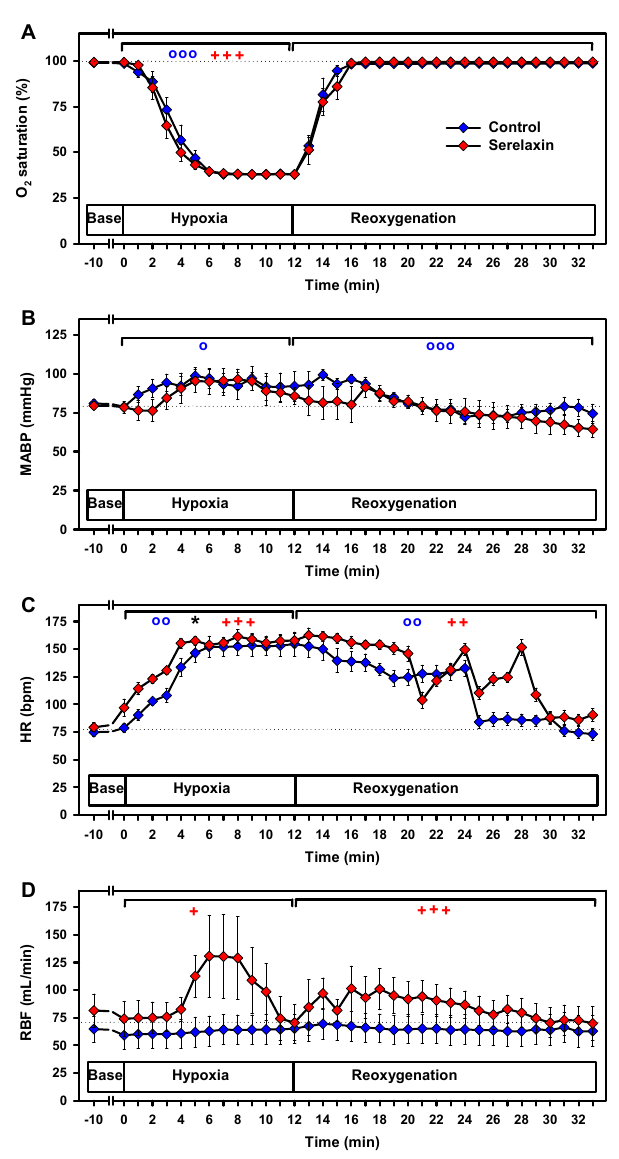
Figure 3. Effects of hypoxia and reoxygenation on vital parameters. ( A ) oxygen saturation (O 2 saturation), ( B ) mean arterial blood pressure (MABP), ( C ) heart rate (HR), and ( D ) renal blood flow (RBF). Linear mixed models were separately calculated for hypoxia and reoxygenation versus baseline values. o, p < 0.05; oo, p < 0.01; ooo, p < 0.001 for the comparison of the control group with baseline values. + p < 0.05; ++ p < 0.01; +++ p < 0.001 for the comparison of the serelaxin-treated group with baseline values. * p < 0.05 for the comparison between the two experimental groups. Dotted lines indicate baseline